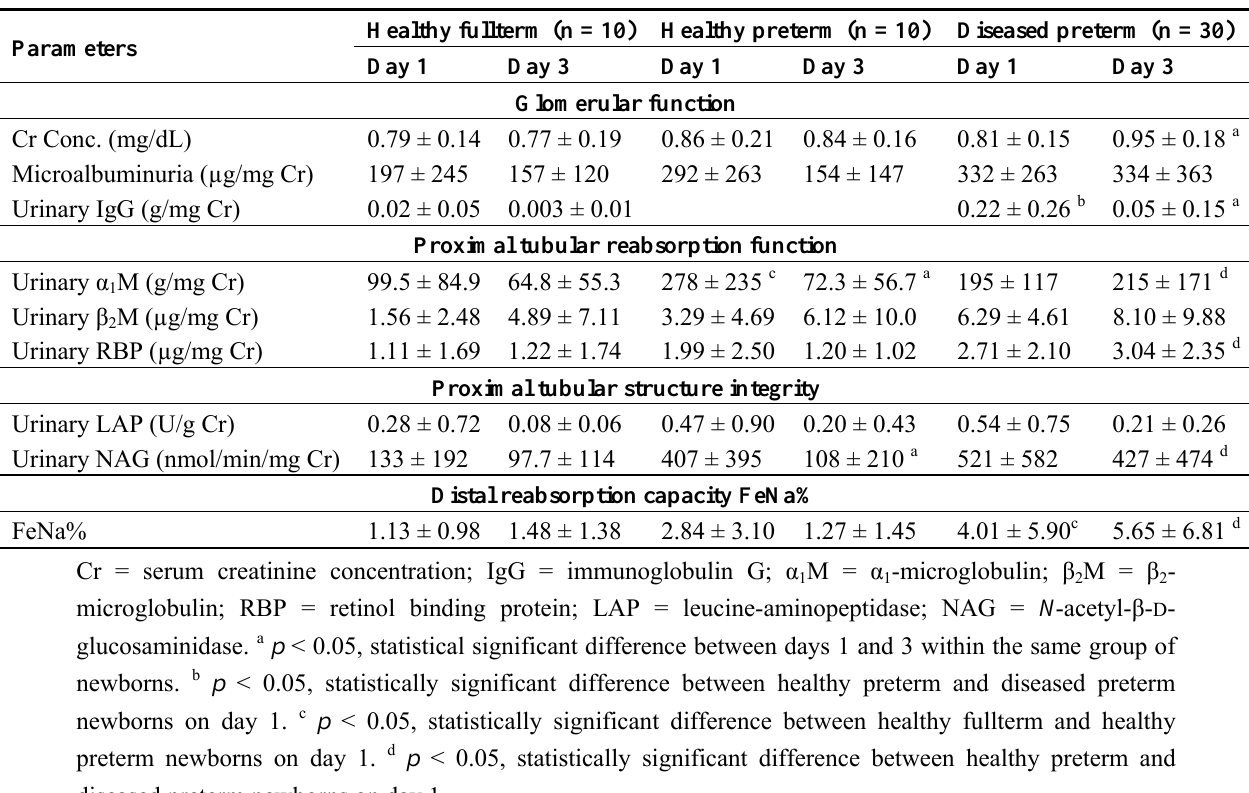
Table 1. Glomerular function, proximal tubular reabsorption function, proximal tubular structure integrity and distal reabsorption capacity in healthy fullterm infants, healthy preterm infants and diseased preterm infants on days 1 and 3 of postnatal life. Figures are the mean ± SD and analyzed using paired t test for parametric data. From Awad et al. [29]. Healthy fullterm (n = 10) Healthy preterm (n = 10) Diseased preterm (n = 30) Parameters Day 1 Day 3 Day 1 Day 3 Day 1 Day 3 Glomerular function Cr Conc. (mg/dL) 0.79 ± 0.14 0.77 ± 0.19 0.86 ± 0.21 0.84 ± 0.16 0.81 ± 0.15 0.95 ± 0.18 a Microalbuminuria (µg/mg Cr) 197 ± 245 157 ± 120 292 ± 263 154 ± 147 332 ± 263 334 ± 363 Urinary IgG (g/mg Cr) 0.02 ± 0.05 0.003 ± 0.01 0.22 ± 0.26 b 0.05 ± 0.15 a Proximal tubular reabsorption function Urinary α M (g/mg Cr) 99.5 ± 84.9 64.8 ± 55.3 278 ± 235 c 72.3 ± 56.7 a 195 ± 117 215 ± 171 d 1 Urinary β M (µg/mg Cr) 1.56 ± 2.48 4.89 ± 7.11 3.29 ± 4.69 6.12 ± 10.0 6.29 ± 4.61 8.10 ± 9.88 2 Urinary RBP (µg/mg Cr) 1.11 ± 1.69 1.22 ± 1.74 1.99 ± 2.50 1.20 ± 1.02 2.71 ± 2.10 3.04 ± 2.35 d Proximal tubular structure integrity Urinary LAP (U/g Cr) 0.28 ± 0.72 0.08 ± 0.06 0.47 ± 0.90 0.20 ± 0.43 0.54 ± 0.75 0.21 ± 0.26 Urinary NAG (nmol/min/mg Cr) 133 ± 192 97.7 ± 114 407 ± 395 108 ± 210 a 521 ± 582 427 ± 474 d Distal reabsorption capacity FeNa% FeNa% 1.13 ± 0.98 1.48 ± 1.38 2.84 ± 3.10 1.27 ± 1.45 4.01 ± 5.90 c 5.65 ± 6.81 d Cr = serum creatinine concentration; IgG = immunoglobulin G; α M = α -microglobulin; β M = β - 1 1 2 2 microglobulin; RBP = retinol binding protein; LAP = leucine-aminopeptidase; NAG = N -acetyl- β - D - glucosaminidase. a p < 0.05, statistical significant difference between days 1 and 3 within the same group of newborns. b p < 0.05, statistically significant difference between healthy preterm and diseased